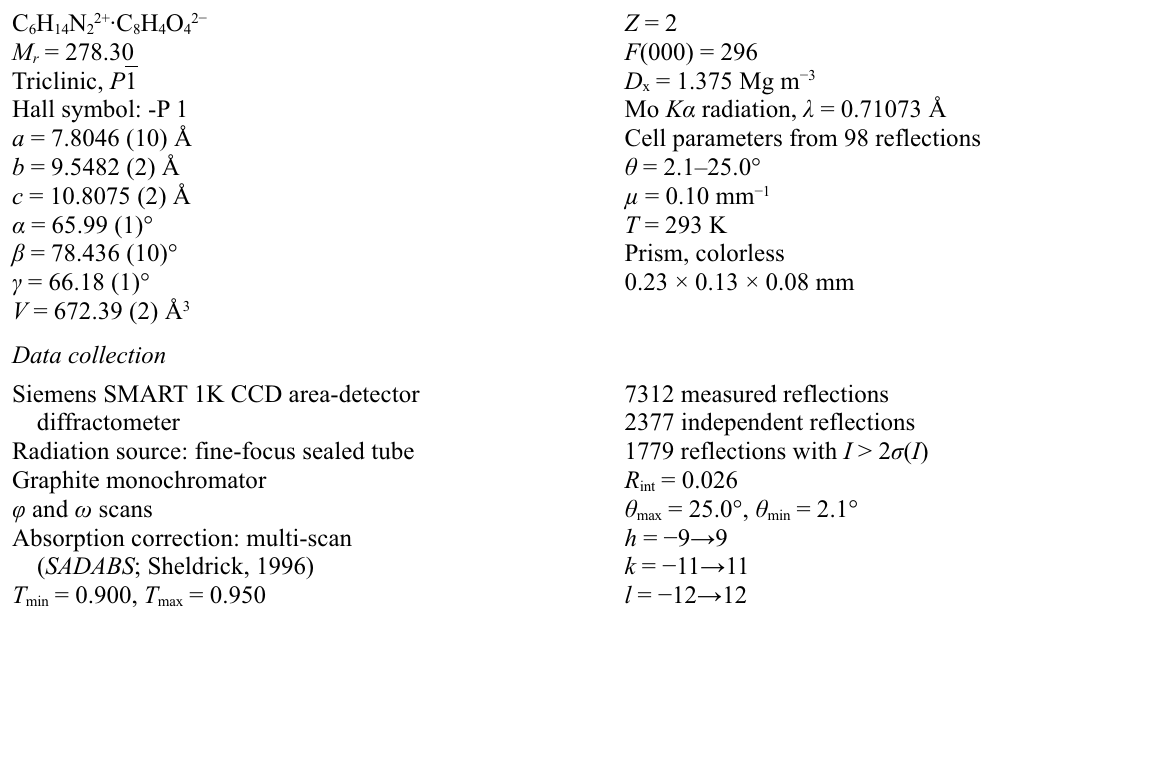
The unit-cell packing of the title compound, showing the hydrogen bonding chains (symmetry code: a = 2 + x , -1 + y , z ). 1,4-Diazoniabicyclo[2.2.2]octane terephthalate Crystal